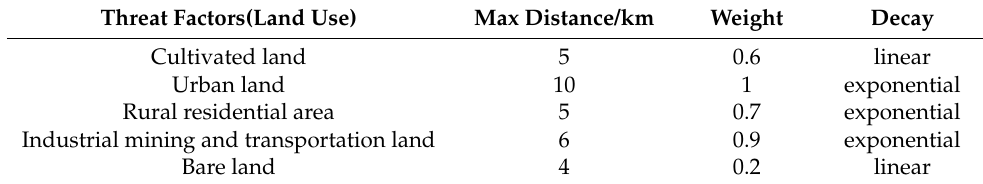
Table 1. Attributes of threat data with different land